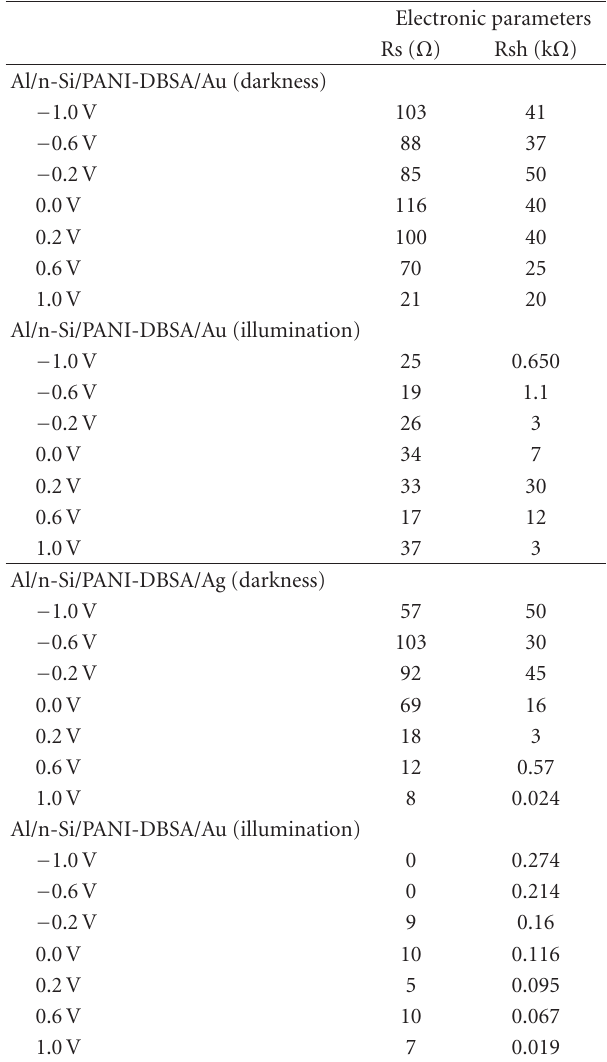
Table 3: Characteristic electronic parameters extracted from impedance spectroscopy of the herterojunctions under darkness and